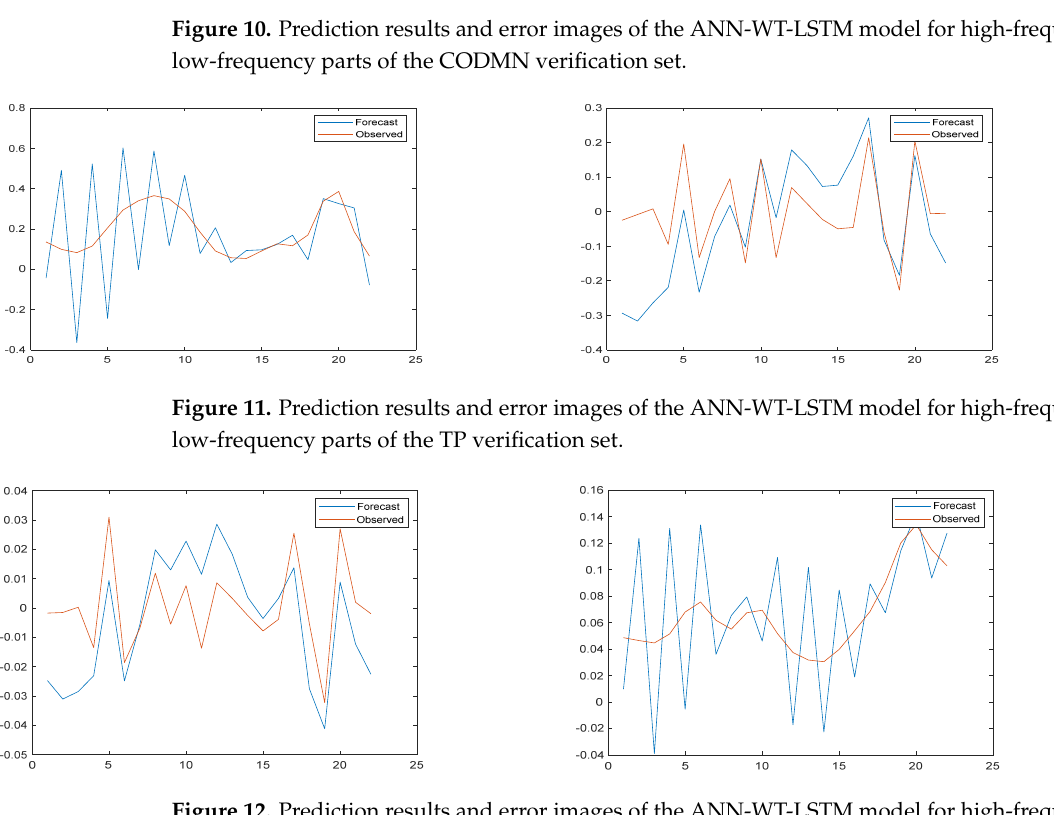
Figure 12. Prediction results and error images of the ANN-WT-LSTM model for high-frequency and low-frequency parts of the NH3-N verification set.